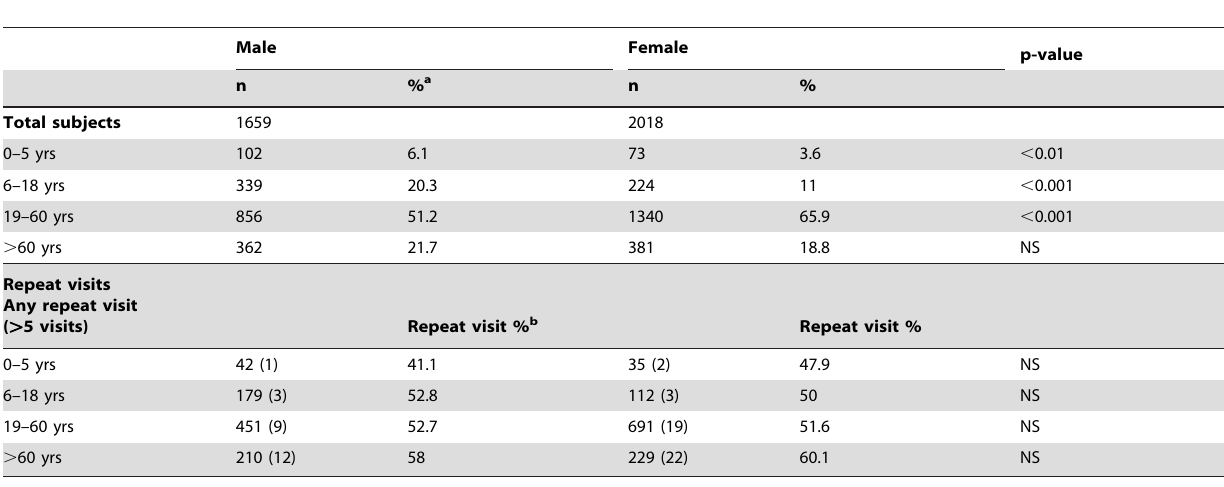
Table 1. Details of Utilization of the eHealth